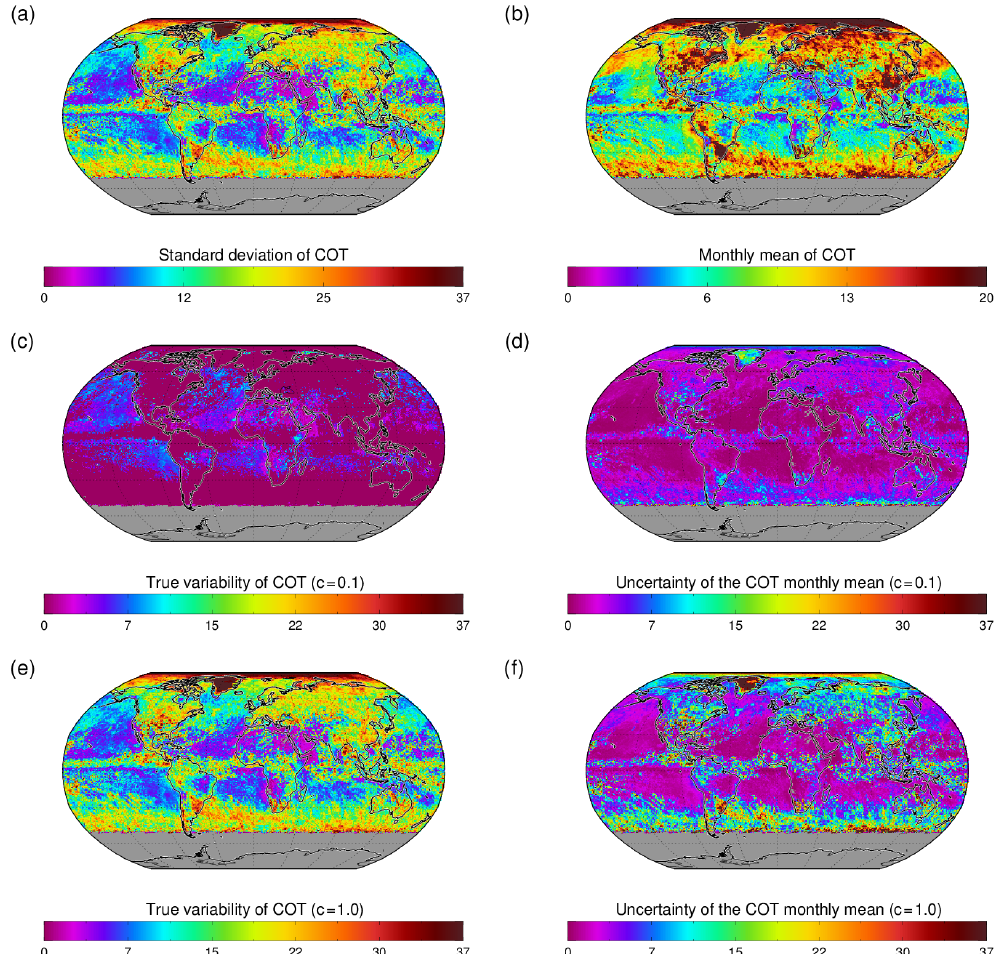
Figure 4. Monthly standard deviation (a) and monthly mean (b) for cloud optical thickness (COT). Panels (c) and (d) show the estimated natural variability and uncertainty of the mean (d) for a correlation of 0.1. Panels (e) and (f) are the same as panels (c) and (d) but for an uncertainty correlation of 1.0. All data are from AVHRR-PM in June